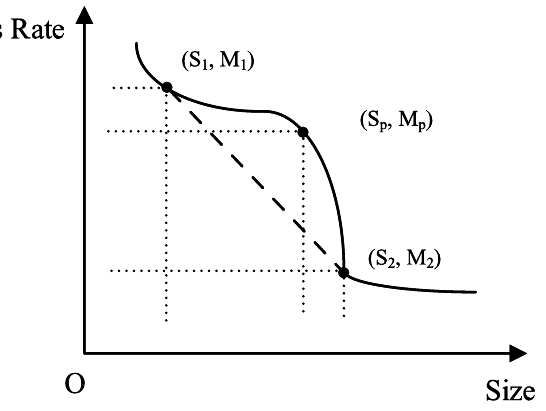
Figure 6. The Example of Partition Point.